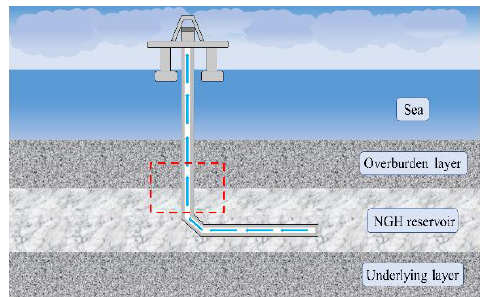
Figure 2. Schematic diagram of a wellbore and the layer location in NGHs extraction.